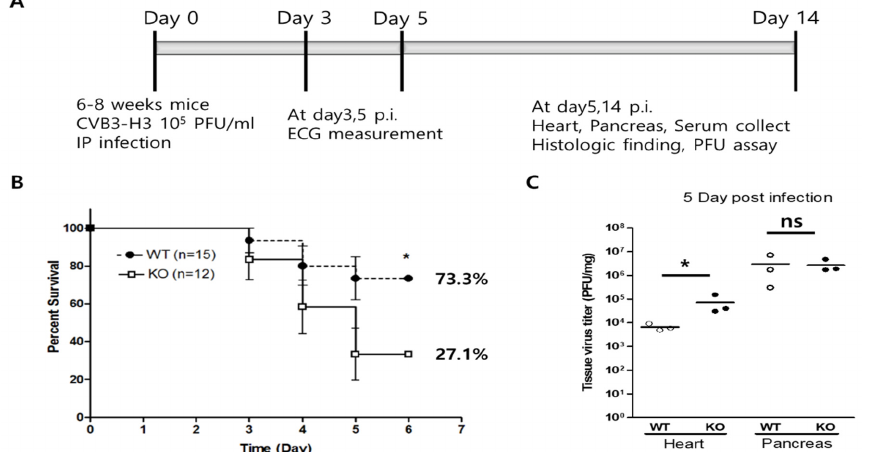
Figure 2. AKT2 deletion increased mouse mortality and heart virus replication. ( A ) CVB3 was injected intraperitoneally into WT and KO mice. ( B ) The survival rate of the mice was recorded on Day 14 post-infection (p.i). ( C ) The heart and pancreas were lysed on Day 5 p.i. Tissue lysates were subjected to a plaque-forming unit (PFU) assay to measure tissue virus titers. All data are the means ± s.e.m. * p < 0.05 according to a two-tailed Student’s t